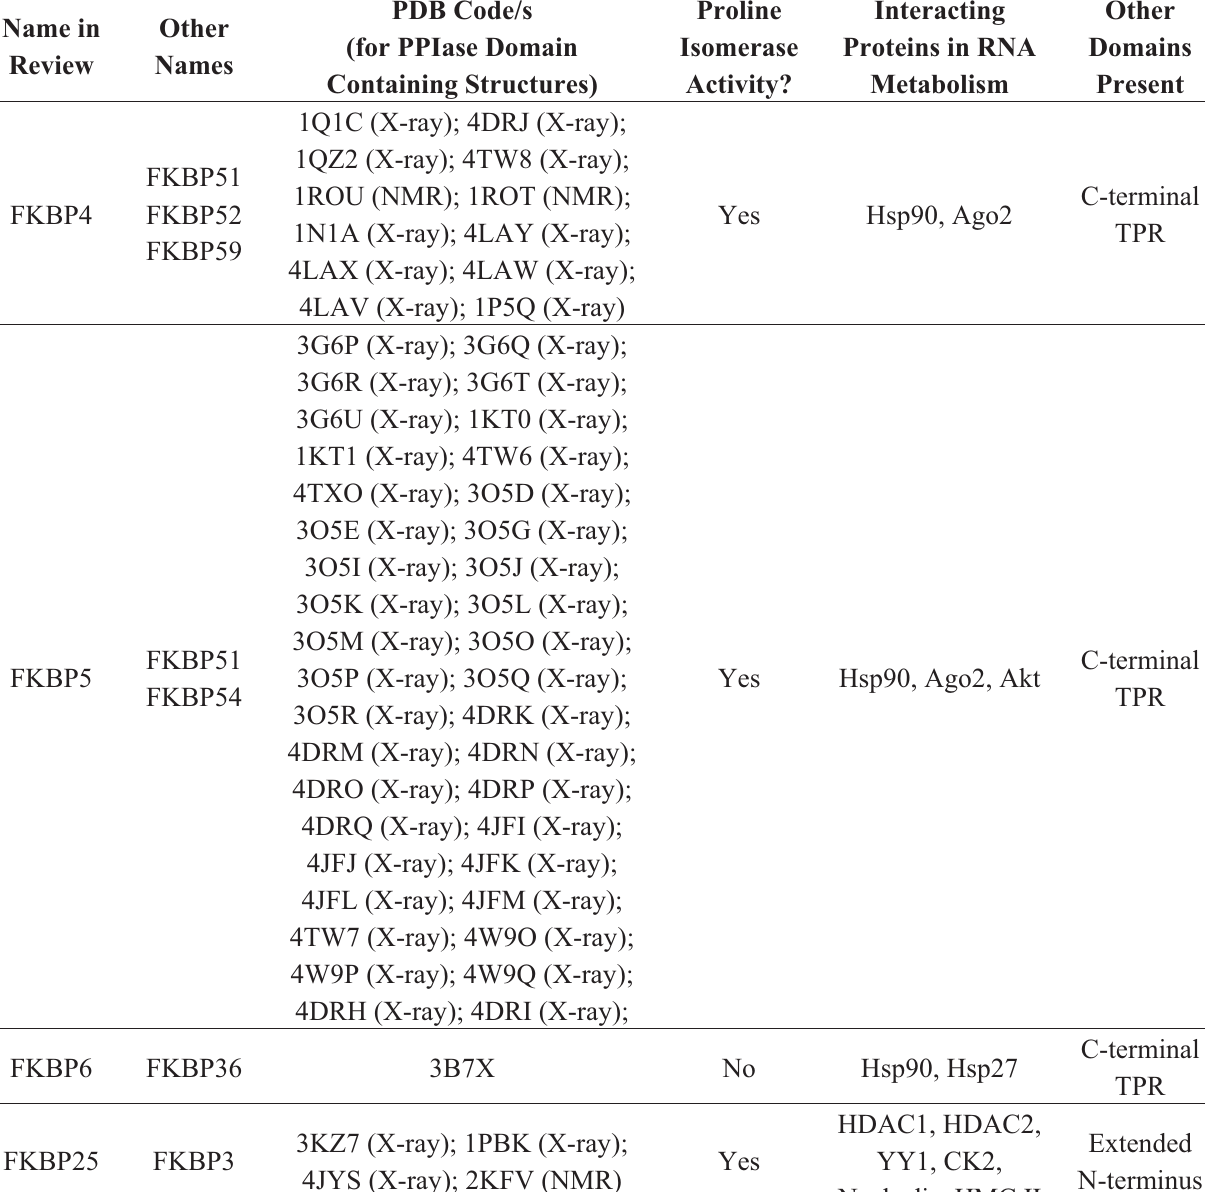
Table 2. Summary of FKBPs involved in RNA-mediated gene